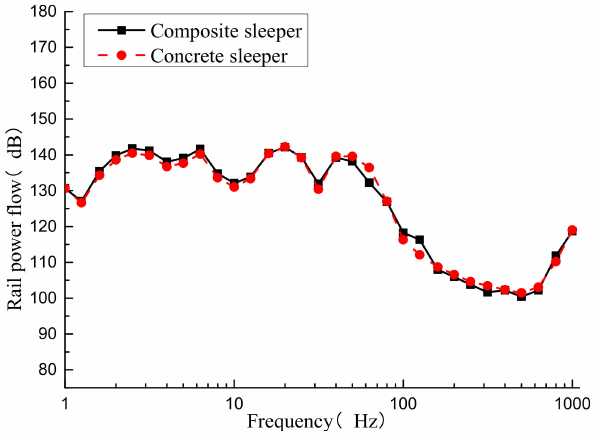
Figure 8. Rail power flow.